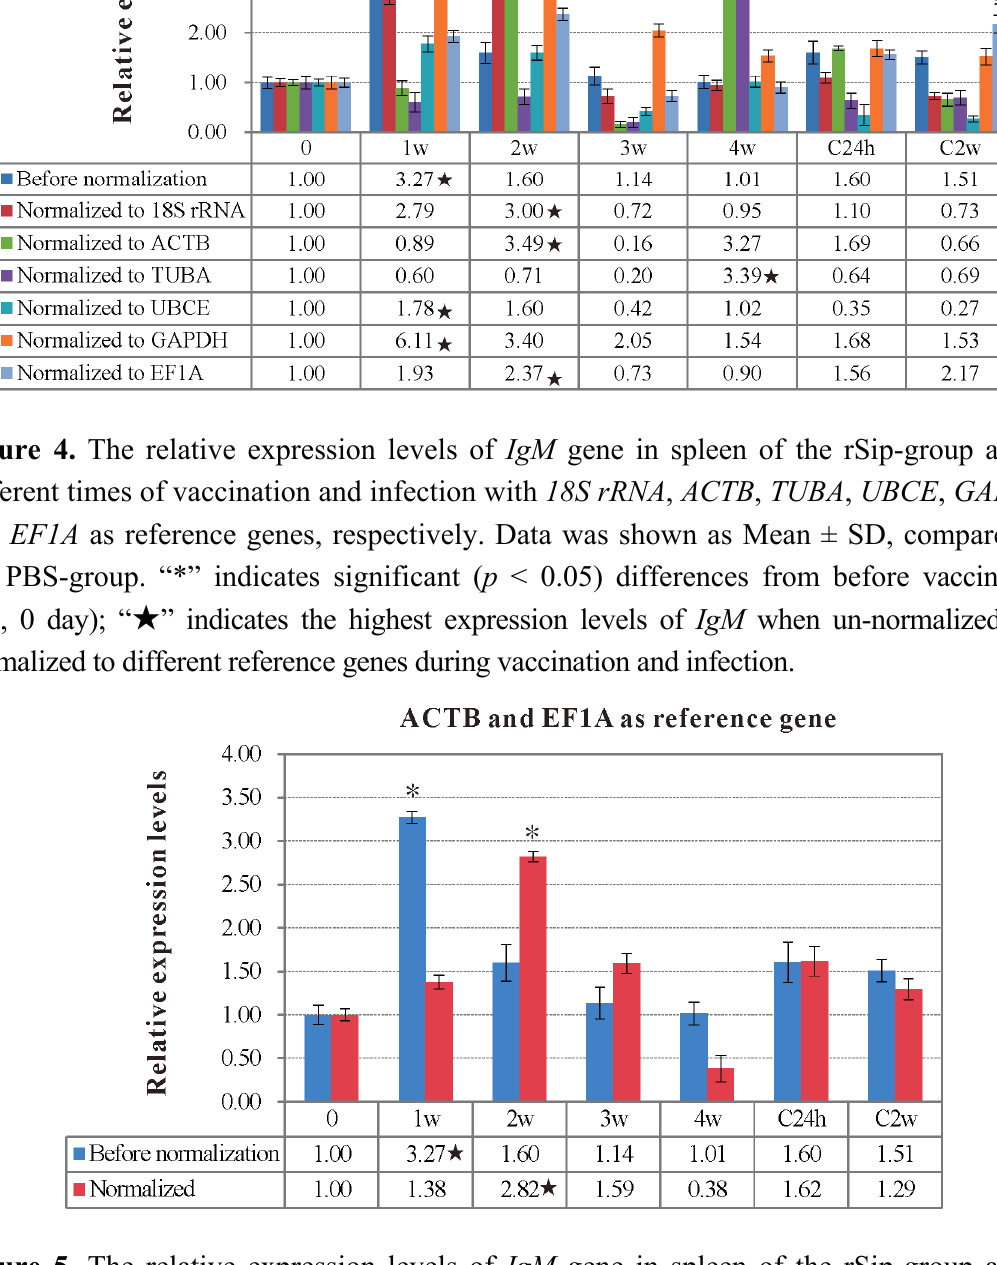
Figure 5. The relative expression levels of IgM gene in spleen of the rSip-group at the different time of vaccination and infection with ACTB and EF1A together as reference gene. Data was shown as mean ± SD, which compared to the PBS-group. “*” indicates significant ( p < 0.05) differences from before vaccination ( i.e. , 0 day); “ ★ ” indicates the highest expression levels of IgM when unnormalized or normalized to two reference genes ( ACTB and EF1A ) during the vaccination and